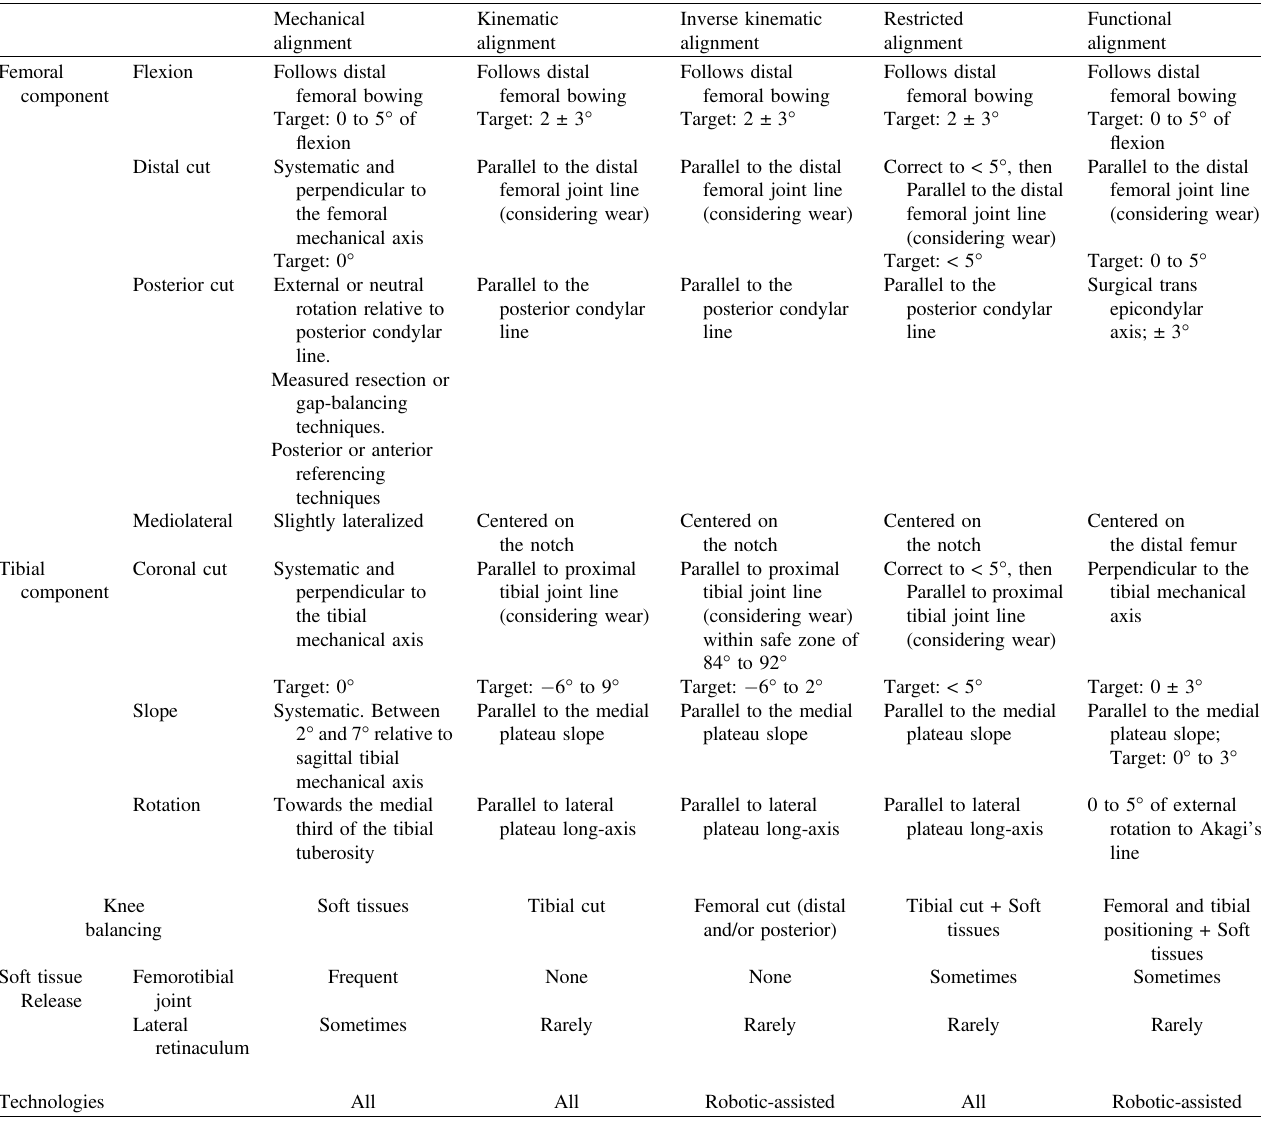
Table 1. Surgical parameters for each kind of